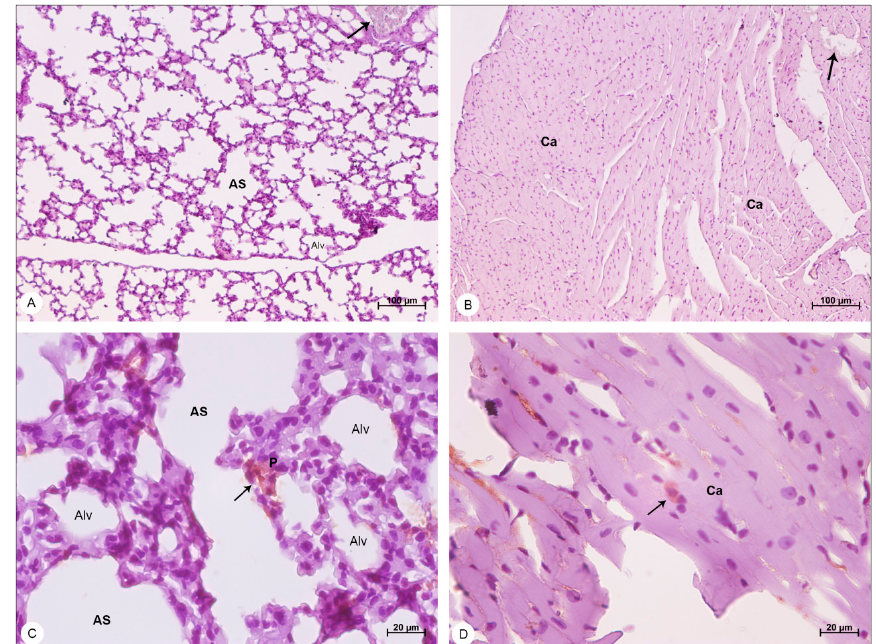
Figure 9. Lung and heart samples of BALB/c mice, counterstained with Harris hematoxylin and observed in bright field microscope, showing detection of the NS3 protein. ( A ) Negative control lung sample. Alveolar sac (AS); alveolus (Alv); erythrocytes showing no peroxidase reaction (arrow). ( B ) Negative control heart sample. Cardiomyocyte (Ca); erythrocytes showing no peroxidase reaction (arrows). ( C ) DENV-4-infected lung sample. Pneumocytes (P); areas of DENV-4 antigen detection (arrow). ( D ) DENV-4-infected heart sample. Areas of DENV-4 antigen detection (arrow). Magnification ( A ) = 50 × ; ( B ) = 50 × , ( C ) = 400 × ; ( D ) = 400 ×